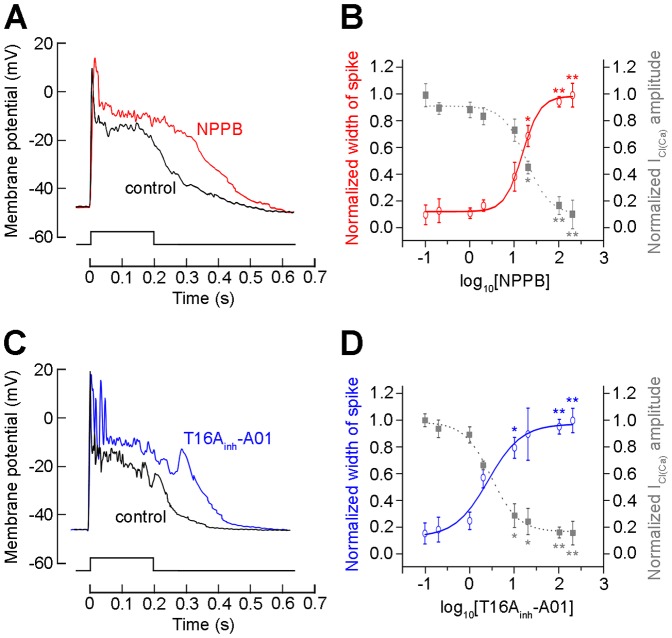
The physiological role of ICl(Ca) during membrane depolarization was examined using NPPB and T16Ainh-A01.
A. The bipolar cell membrane potential was adjusted to close to −45 mV with a steady hyperpolarizing current. A distinctive slow depolarizing potential that followed the Ca2+-dependent transient potentials was elicited by a current injection of 0.5 nA for 200 ms (n = 11). The extracellular application of 100 µM NPPB enhanced the depolarizing membrane potential compared with the control experiment. B. The dose-dependent decrease elicited by NPPB on Itail amplitude obtained under the voltage-clamping mode (gray) was compared with the dose-dependent increase elicited by NPPB on the width of current-evoked spikes (red). The half-maximal dose (EC50) of NPPB that was necessary to increase the width was similar to EC50 of NPPB that inhibited ICl(Ca) (15.0 vs. 18.4 µM). C. In addition, T16Ainh-A01 application enhanced the depolarizing membrane potential (n = 8). D. The dose-dependent decrease elicited by T16Ainh-A01 on Itail amplitude obtained under the voltage-clamping mode (gray) was compared with the dose-dependent increase elicited by T16Ainh-A01 on the width of current-evoked spike (blue). The half-maximal dose (EC50) of T16Ainh-A01 that was necessary to increase the width was similar to EC50 of T16Ainh-A01 that inhibited ICl(Ca) (2.6 vs. 3.0 µM). Significance was set at P<0.05 (*) and P<0.01 (**).